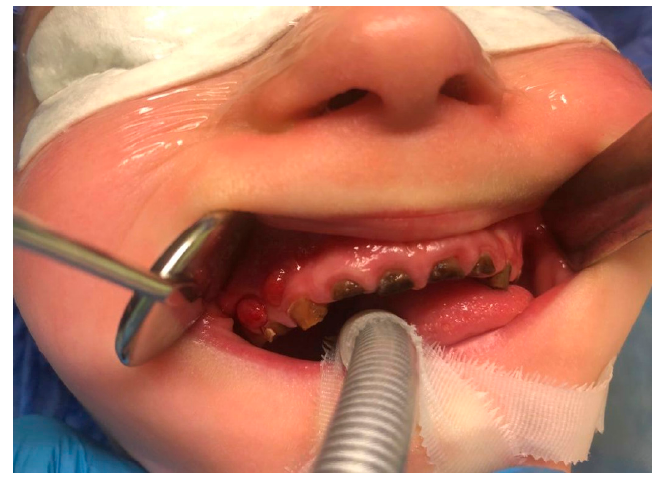
Figure 7. Odontogenic source of infection of the maxilla.